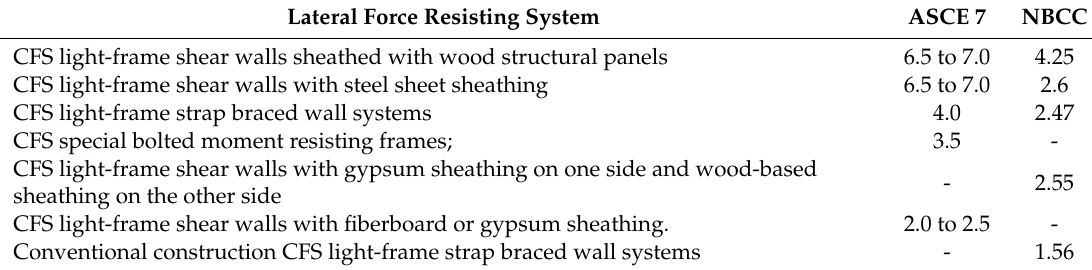
Table 1. Force reduction factor (R) given by ASCE 7 and NBCC Codes for lateral force resisting systems defined by AISI